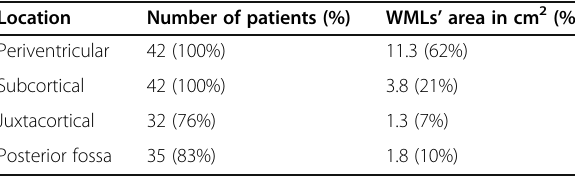
Table 1 The distribution of WMLs in the study